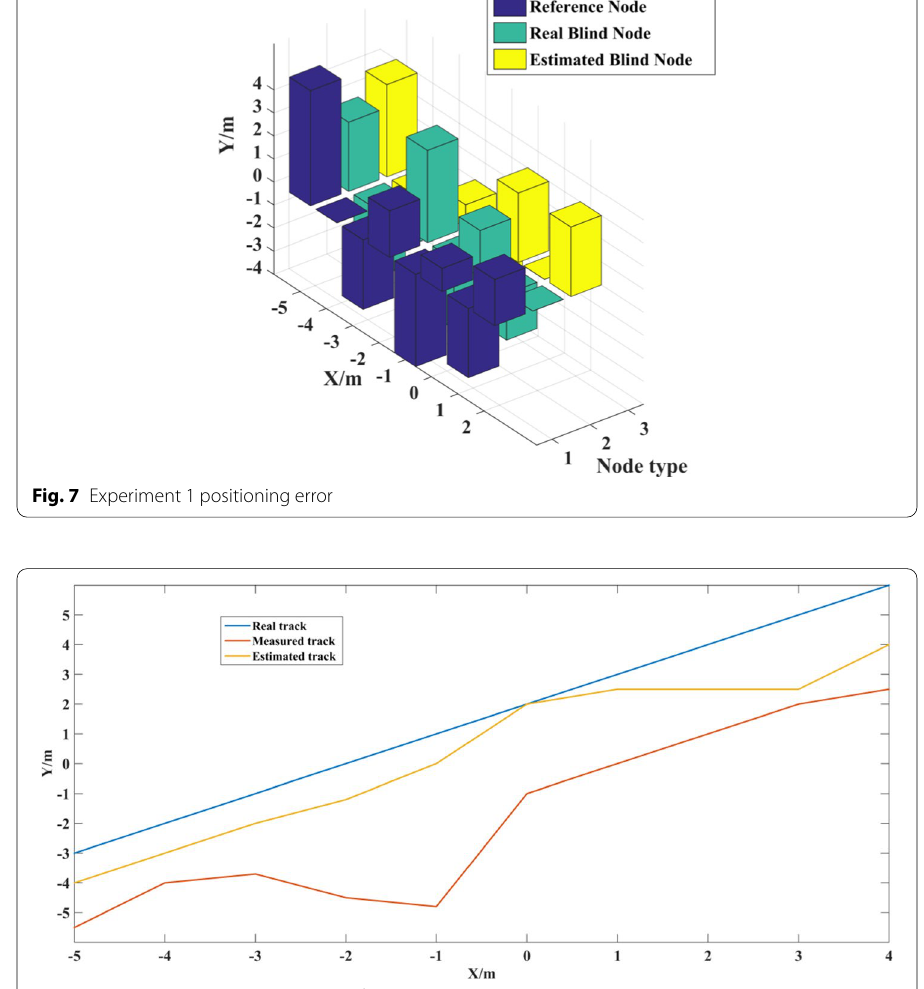
Fig. 8 Experiment 2 positioning test